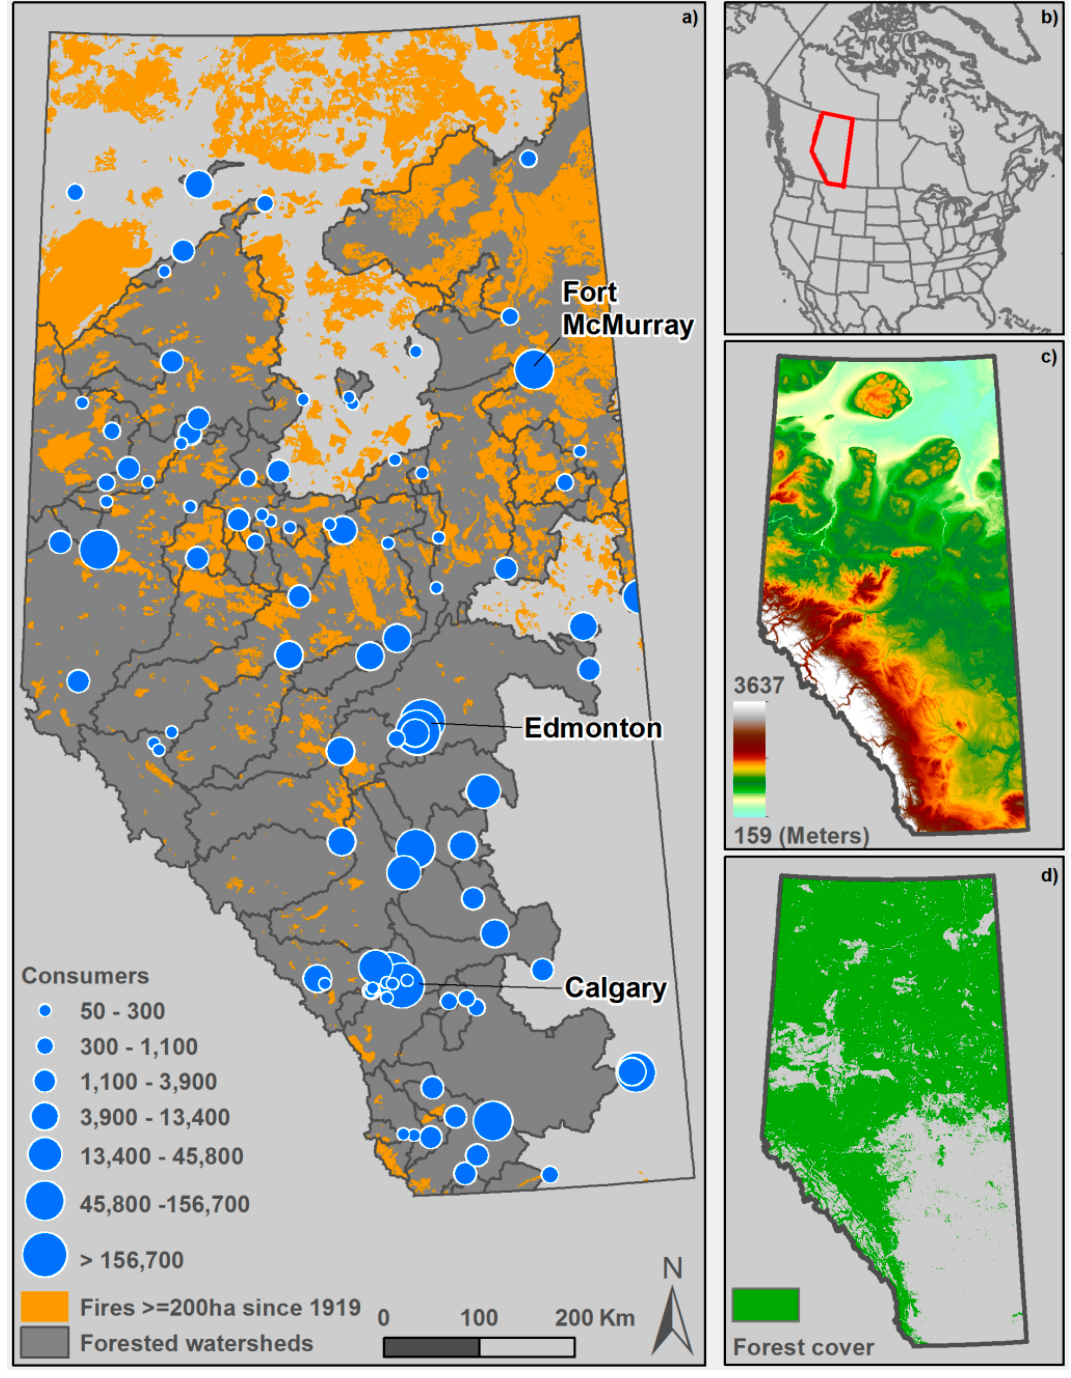
Figure 1. Details of the study area, including: ( a ) the location of drinking-water treatment facilities reliant on surface water supplies from forested watersheds in Alberta (symbol size indicates population size class served by the utility) and historic spatial distribution of large fires ( > 200 ha) [40]; ( b ) the location of Alberta in North America; ( c ) Alberta terrain (elevation); and ( d ) Alberta forest cover.